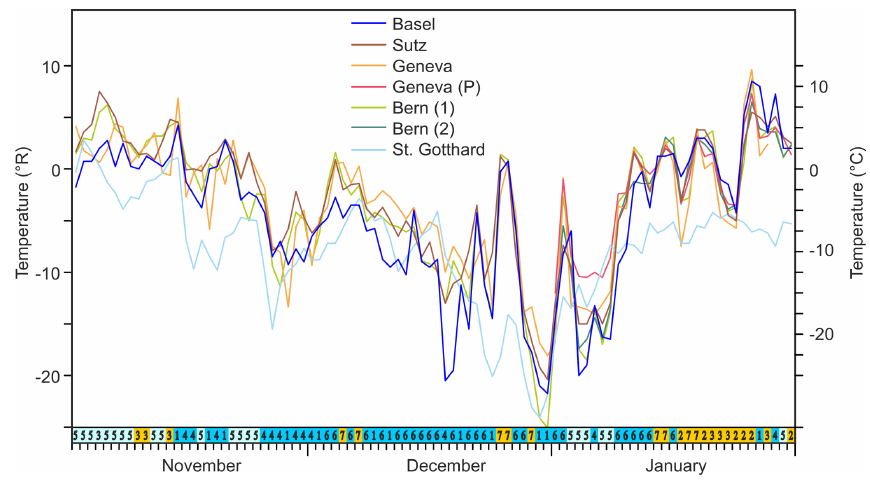
Figure 6. Temperature at Geneva, Basel, Bern, Sutz, and St. Gotthard Pass in November to January 1788/89. If several observations were made per day, we show the sunrise temperature. Note that these are the digitised raw data in degrees Réaumur. The series from Basel was shifted upward by 10 ◦ for visualisation. The bottom bar indicates the weather type according to Schwander et al.